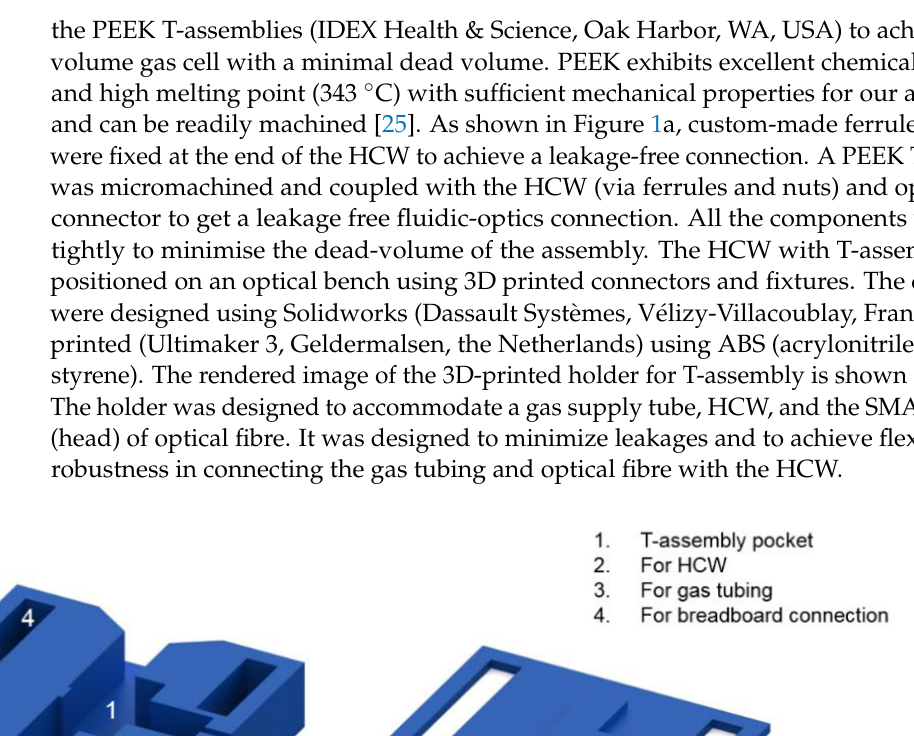
Figure 2. The rendered image of the 3D-printed holder for the two ends of the absorbance detector. The T-assembly with connected optical fibre, gas tube, and hollow-core waveguide (HCW) was placed inside the holder, and covered by the top lid to minimise any misalignment and vibrations. The whole assembly was then fixed on the optical bread board with screws.